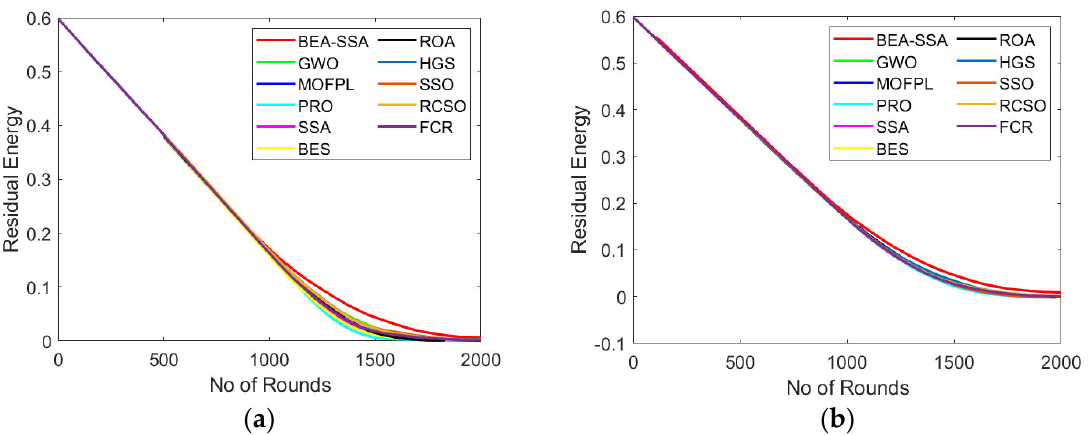
Figure 7. Residual energy analysis using BEA ‐ SSA compared with the other models [20–22,26] for node counts of ( a ) 100 and ( b ) 200.